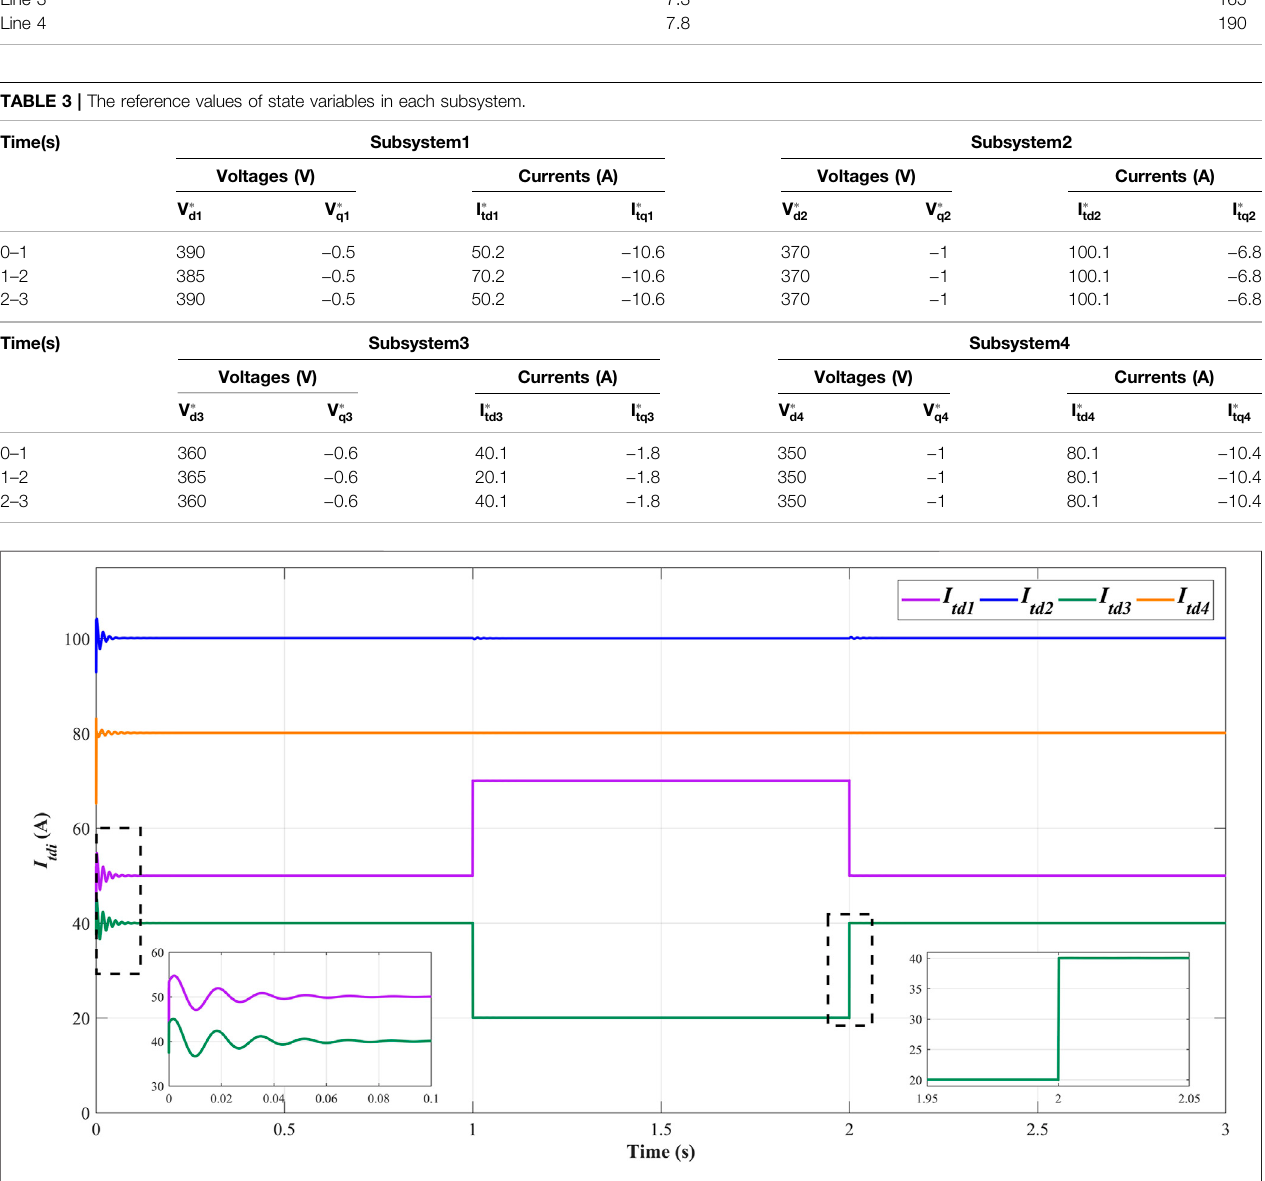
FIGURE 2 | Time evolution of the d -component of currents generated from DGus.